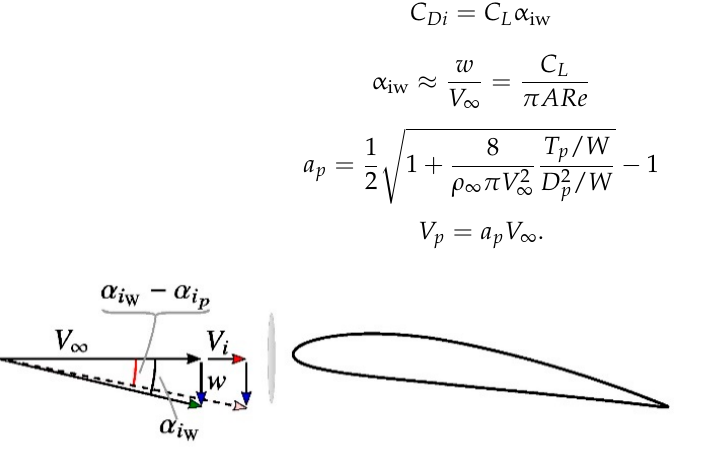
Figure 17. Induced angles due to wing and actuator disk.